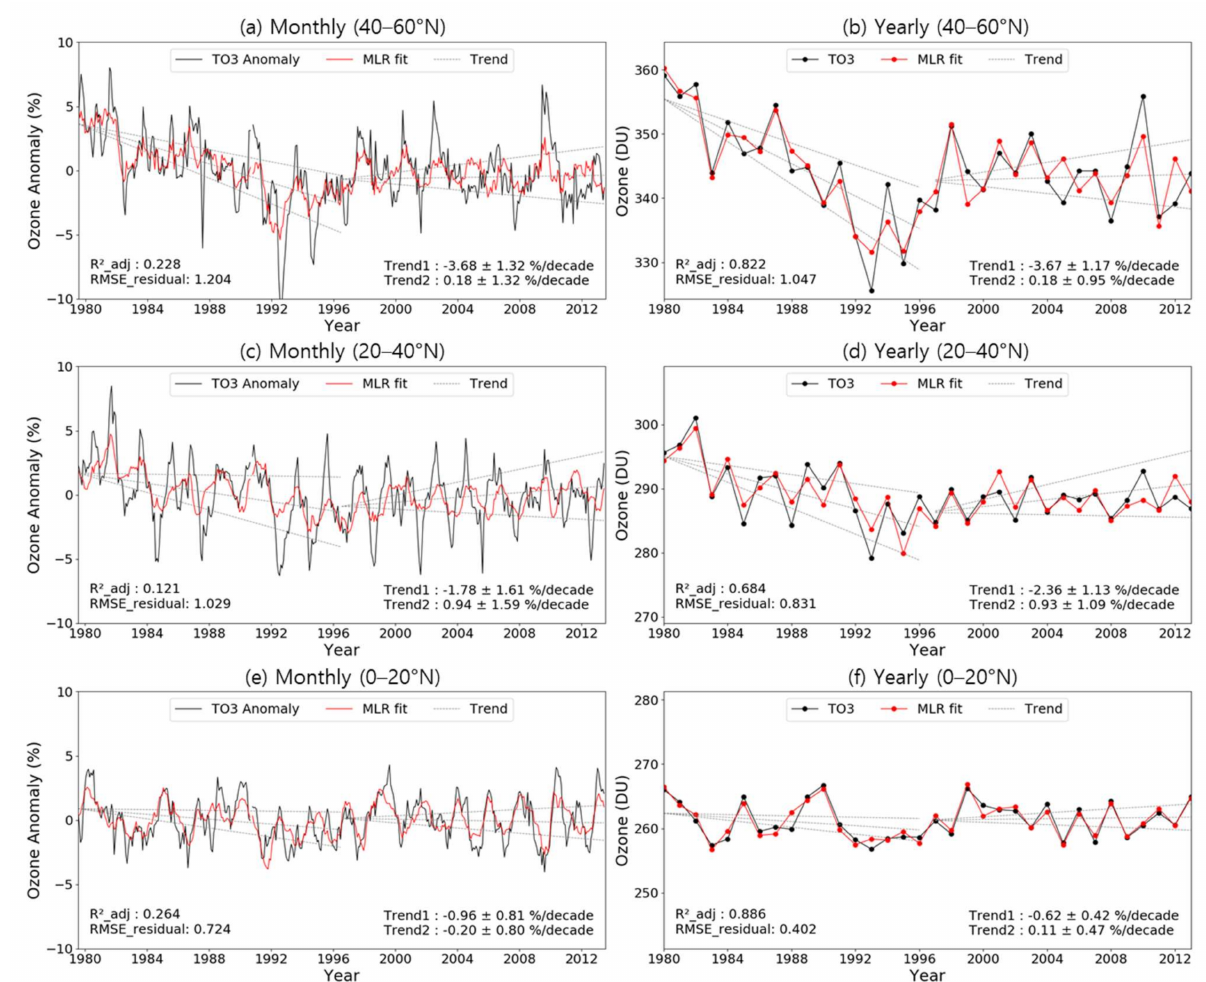
Figure 1. Time-series of the monthly ( a , c , e ) and yearly ( b , d , f ) SBUV total column ozone for three latitudes of 40–60 ◦ N ( a , b ), 20–40 ◦ N ( c , d ), and 0–20 ◦ N ( e , f ). The black and red lines represent the observed and MLR fitted ozone, respectively. Linear trends (gray dotted line) and 2 σ uncertainties, as derived from the MLR, are indicated for the pre-1997 (Trend1, 1980–1996) and post–1997 (Trend2, 1997–2013)